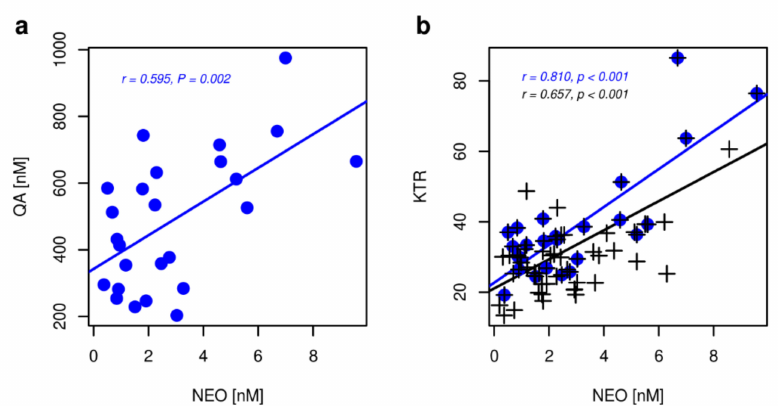
Figure A3. Graph of ( a ) neurotoxin QA correlation with inflammatory marker NEO in plasma of SCAS patients (blue color) and ( b ) correlation of inflammatory markers KTR and NEO in plasma of SCAS patients and in plasma of all probands (black color). Abbreviations: QA: quinolinic acid; NEO: neopterin; KTR: 1000 × [KYN] /